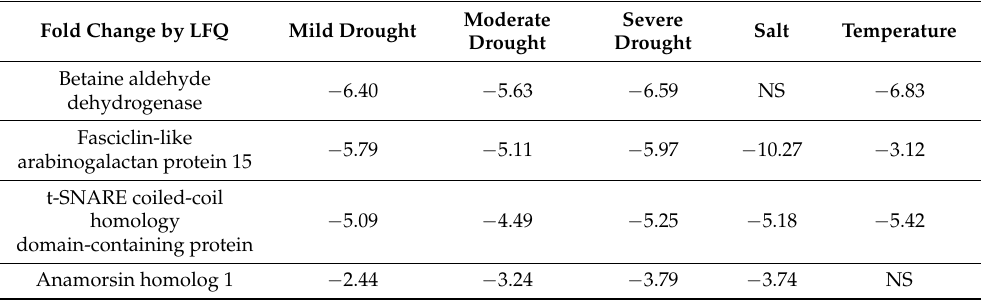
Table 5. Fold change of proteins from LFQ experiment under different abiotic stresses in comparison with control plants. (NS) indicates no statistically significant change between control and stress condition, according to a Student t -test ( p -value < 0.05). Moderate Severe Fold Change by LFQ Mild Drought Salt Temperature Drought Drought Betaine aldehyde − 6.40 − dehydrogenase